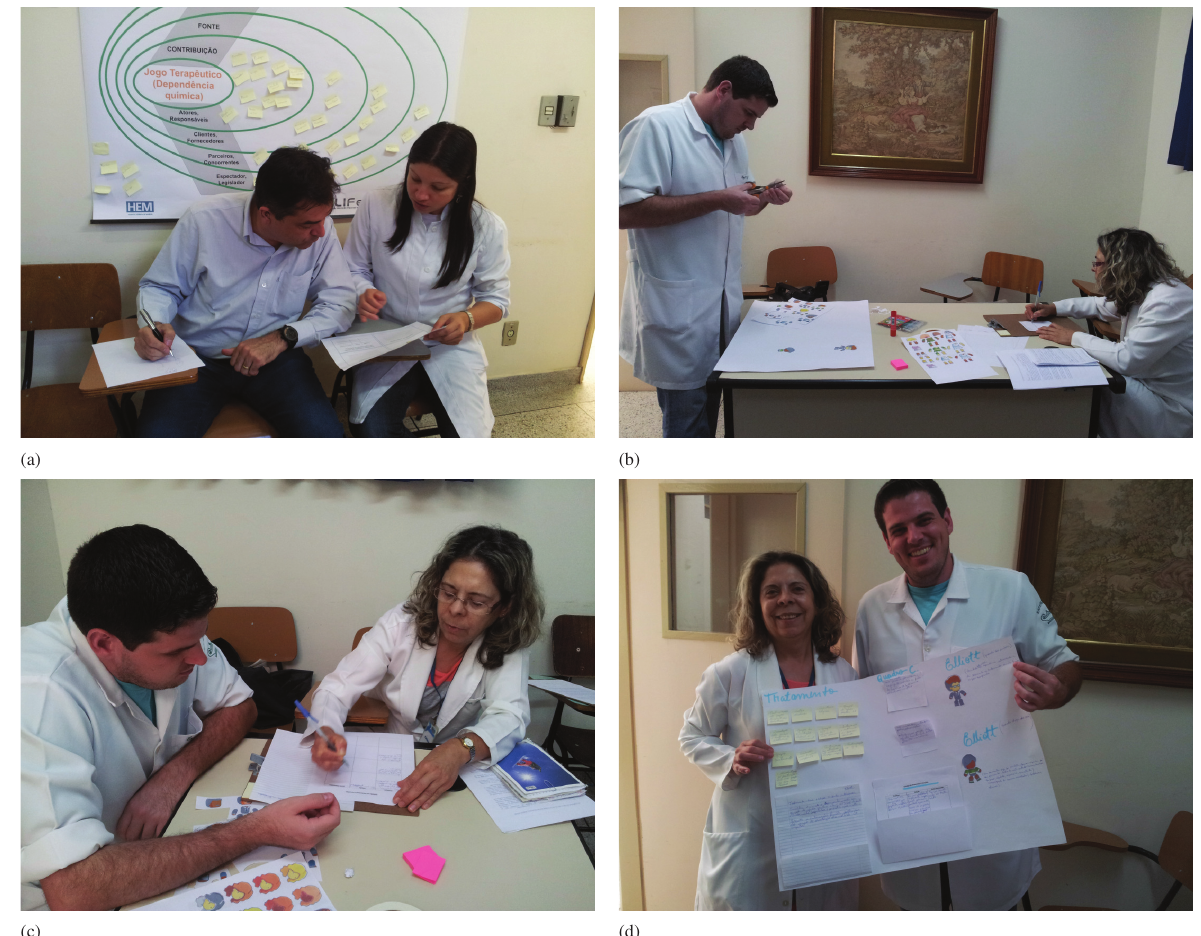
Fig. 6. Healthcare professionals contributing to step III-2 of the Personas Enrichment Process.